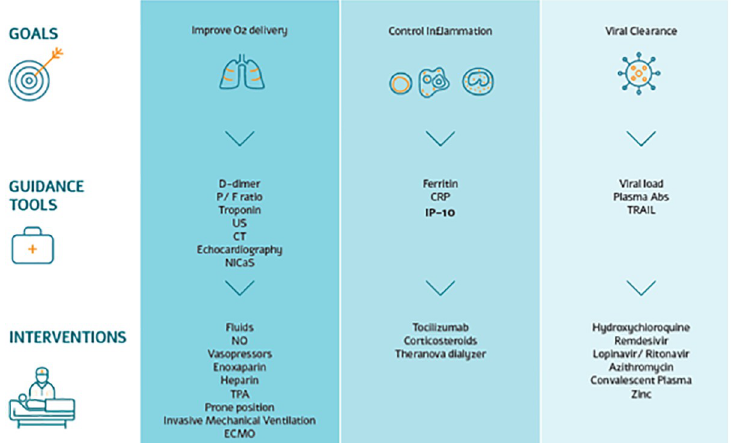
Fig 1. Overview of the dynamic clinical decision support protocol used in managing SARS-CoV-2 patients admitted to a COVID-19-dedicated medical center. Note that at the time the study was performed, multiple treatments and clinical decision protocols were being developed globally and employed despite the limited data to support improved outcomes and the research use only indications. P/F ratio, ratio of arterial oxygen partial pressure (P a O 2 ) to fractional inspired oxygen (F i O 2 ); US, ultrasound; CT, computed tomography; NICaS, non-invasive cardiac system; NO, nitric oxide; TPA, tissue plasminogen activator; ECMO, extracorporeal membrane oxygenation; CRP, C- reactive protein; IP-10, interferon γ -induced protein 10; Plasm Abs, plasma antibodies; TRAIL, tumor necrosis factor- related apoptosis-inducing